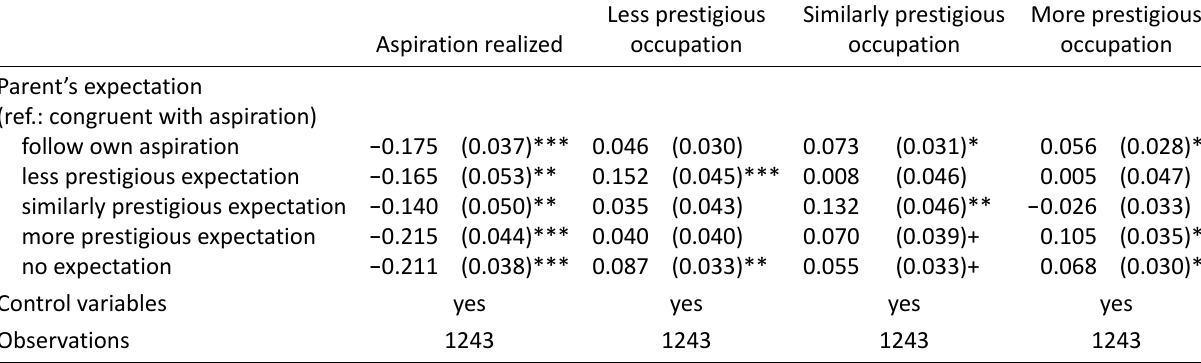
Table 1. Differences in compromise formation by divergent parental